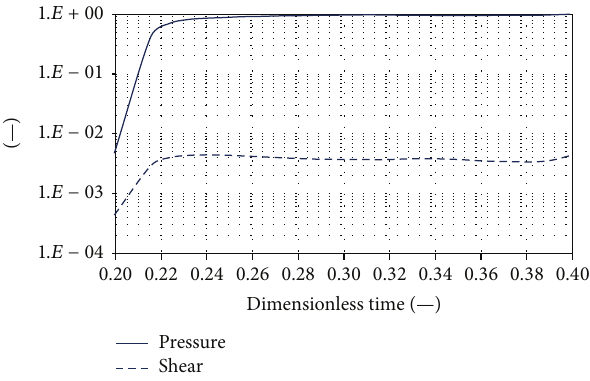
Figure 20: Second impact data related to run 3D-2: normalized cumulative torque curves resulting from pressure and shear